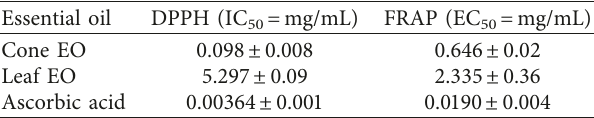
Table 3: Antioxidant activity of the two EOs evaluated by 2,2- diphenyl-1-picrylhydrazyl (DPPH) and ferric reducing antioxidant power (FRAP) assays. Results are average value ± SD of triplicate measurement. The values in the same line with different letters are significantly different ( p < 0 . 05) by Tukey’s multiple range tests.